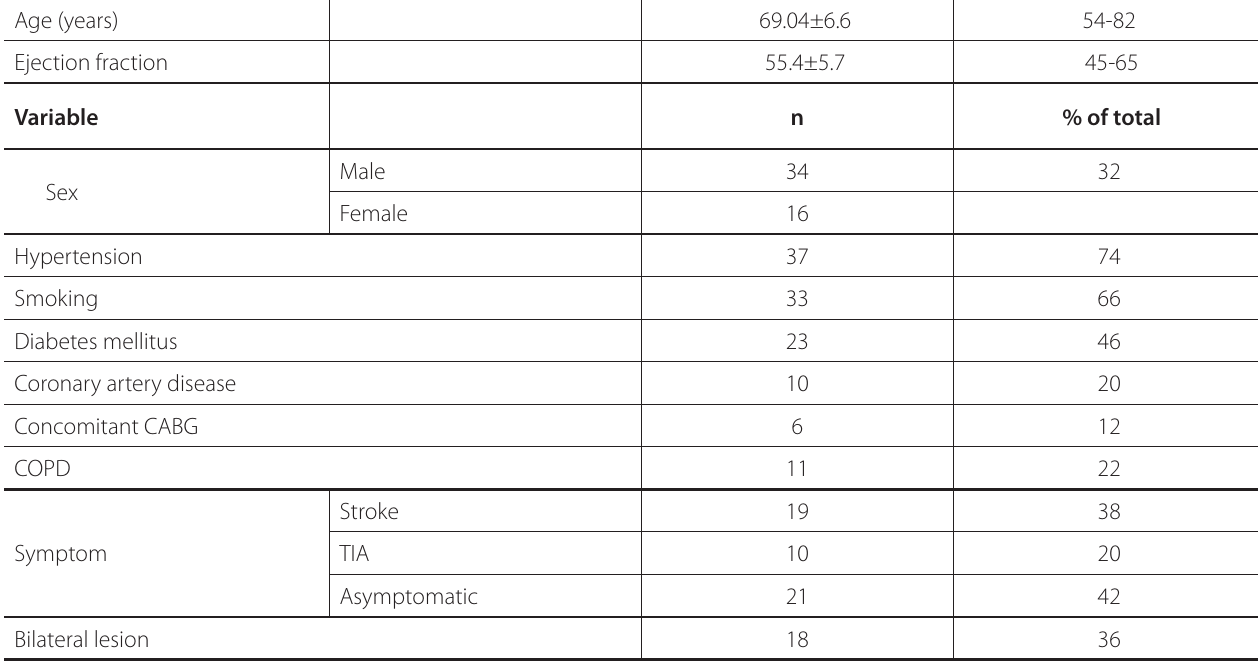
Table 1 . Preoperative patient